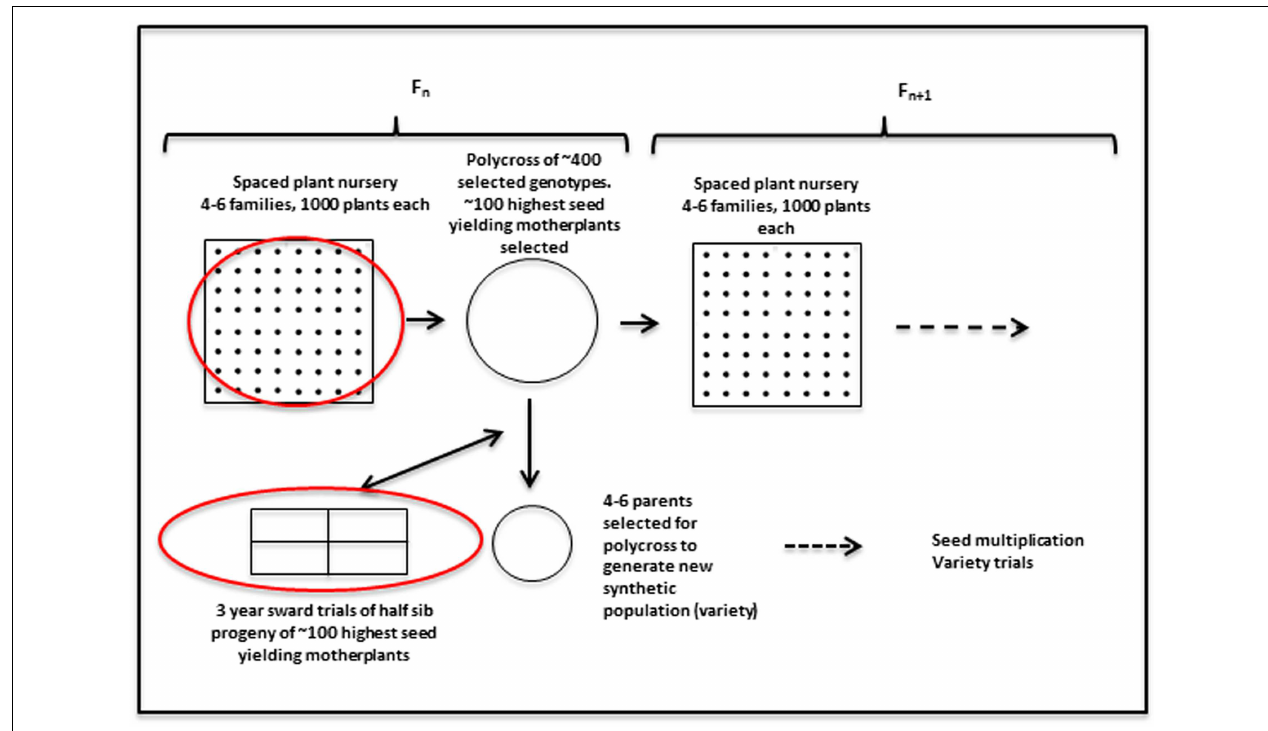
FIGURE 1 | Outline of the recurrent selection breeding program in L. perenne . The red circles indicate stages where genomic selection (GS) can be implemented, given availability of genotypic, and phenotypic data. The work described here is aimed at utilizing the phenotypic data from the sward trials to facilitate prediction of the best mother-plants for new variety